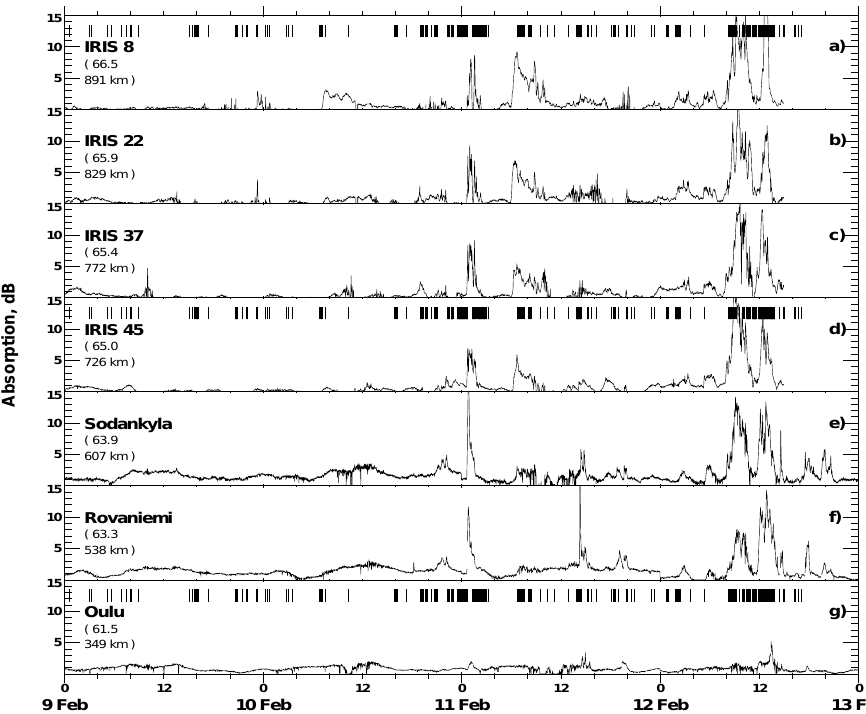
Fig. 4. (a)–(g) Variations of D-region absorption at 12MHz determined by riometers near CUTLASS beam 5, see Fig. 1. Absorption was estimated from original riometer records by applying the f − 2 dependence, where f is the riometer frequency. Vertical bars in panels (a), (d) and (g) indicate the times of HF echo detection over the EISCAT spot of